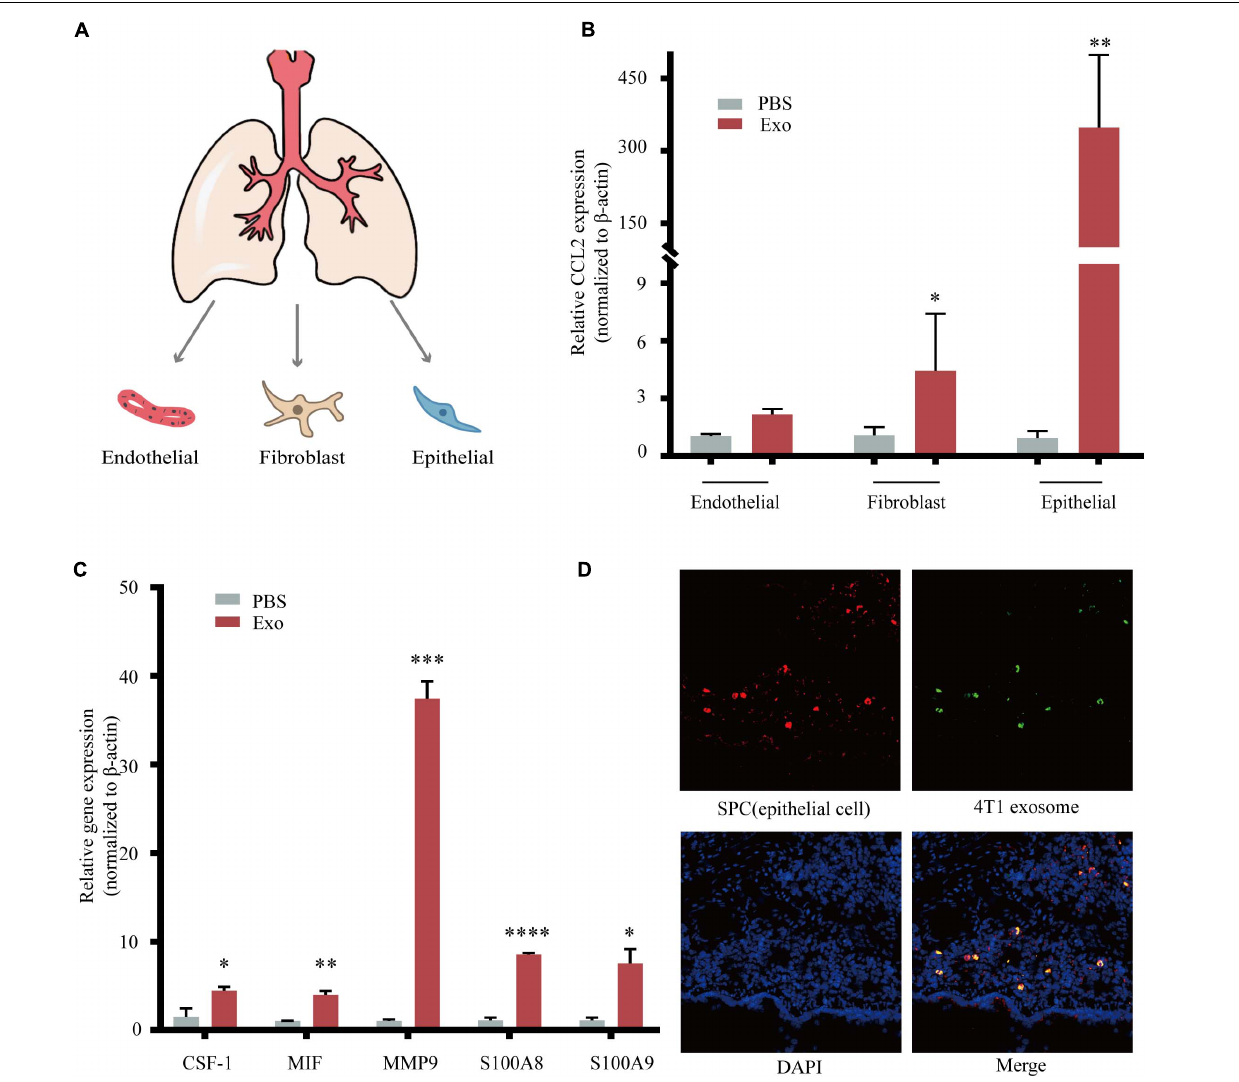
FIGURE 4 | Breast tumor-derived exosomes regulate tumor progression through activation of alveolar epithelial type II cells (AEC II). (A) Isolation of primary lung fibroblasts, AEC II, and pulmonary endothelial cell from mouse lung. (B) mRNA expression of CCL2 in lung fibroblasts, AEC II, and pulmonary endothelial cells treated with PBS or 4T1 derived exosomes. (C) mRNA expression of niche formation associated gene in AEC II treated with PBS or 4T1 derived exosomes. (D) Immunofluorescent analysis of the colocalization of tumor-derived exosome and AEC II. P values were calculated by unpaired Student’s t -test (* P < 0.05, ** P < 0.01, *** P < 0.001, **** P <